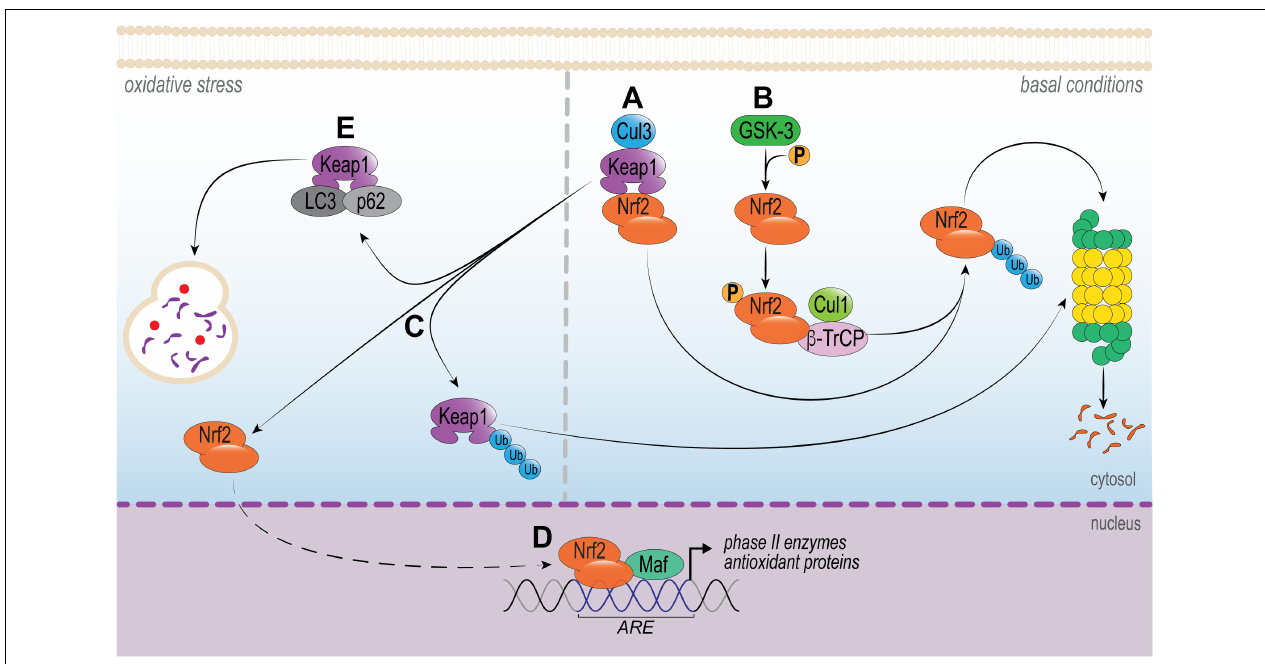
FIGURE 1 | Intracellular signaling pathways that regulate Nrf2. In basal conditions, (A) Nrf2 is sequestered in the cytosol by Keap1 by two motifs (ETGE and DLG), which are essential to recruit Nrf2. Keap1 works as a dimeric redox sensitive substrate adaptor for cullin-based E3 ubiquitin ligase, which inhibits the transcriptional activity of Nrf2 via ubiquitination and proteasomal degradation. This signaling is known as canonical pathway. (B) Alternatively, Nrf2 is also regulated by a non-canonical pathway. The phosphorylation of Nrf2 by GSK-3 facilitates its recognition by β -TrCP, leading to Cul1-mediated ubiquitination, followed by Nrf2 proteasome degradation. Under oxidative stress or pathological conditions, (C,D) Keap1-CUL3 ubiquitin E3 ligase activity decreases and Nrf2 dissociates from Keap1. Nrf2 translocates to the nucleus and heterodimerizes with small musculoaponeurotic fibrosarcoma (Maf) protein and binds to DNA and other transcription partners to setting up a nuclear complex with the ubiquitin-conjugating enzyme UbcM2. These nuclear complexes formed with Nrf2 induce the expression of the ARE-gene battery, such as: NQO1, HMOX1, GCL, GSTs, CAT, SOD, and thioredoxin UDP-glucuronosyltransferase. (E) The multifunctional protein p62 and LC3 acts by sequestration of Keap1, which culminates in its autophagic degradation. As a consequence, Nrf2 can translocate to the nucleus and activate